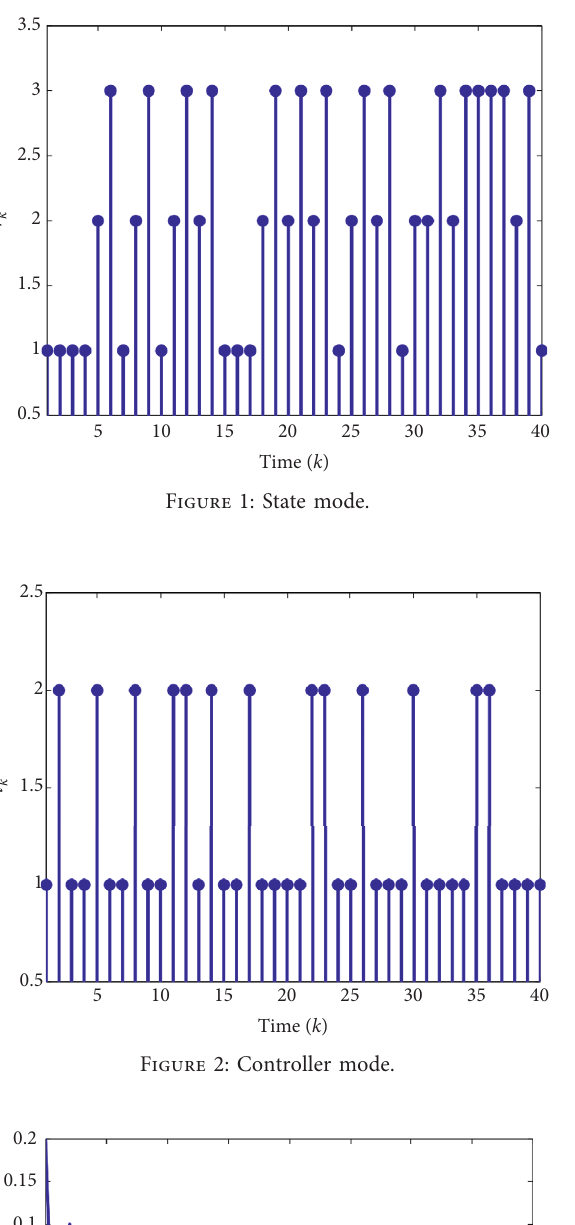
Figure 5: Evolution of γ d ( k ) .